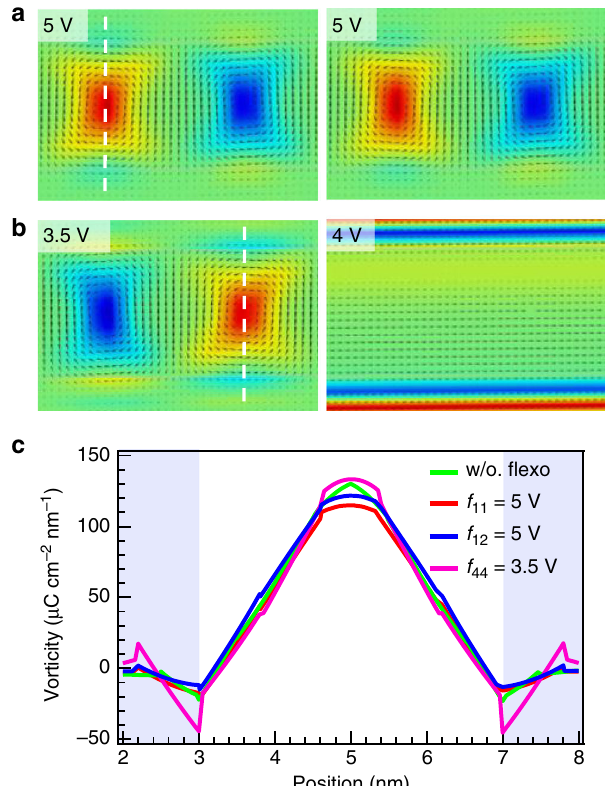
Fig. 3 Modeling the fl exocoupling effects of SrTiO 3 . a , b Typical vortex pair pattern (location marked in Fig. 2a) under the fl exocoupling of the STO layers: f 11 STO = 5 V ( a , left), f 12 STO = 5 V ( a , right), and f 44 STO = 3.5, 4 V ( b ). The polarization vectors (arrows) are overlaid on the vorticity images. c Section line pro fi les of the vorticity along the line marked in a , b under selected fl exocoupling conditions. The lightly blue-shaded region corresponds to STO